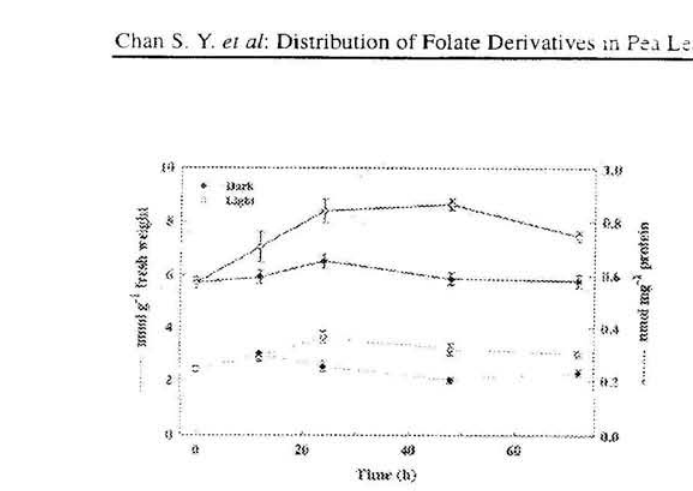
Figure 2. Folate contents of etiolated and greening seedlings. Total folate of pea leaves were determined after 9 d etiolated seedlings were kept in to continuous light for 72 h. Data